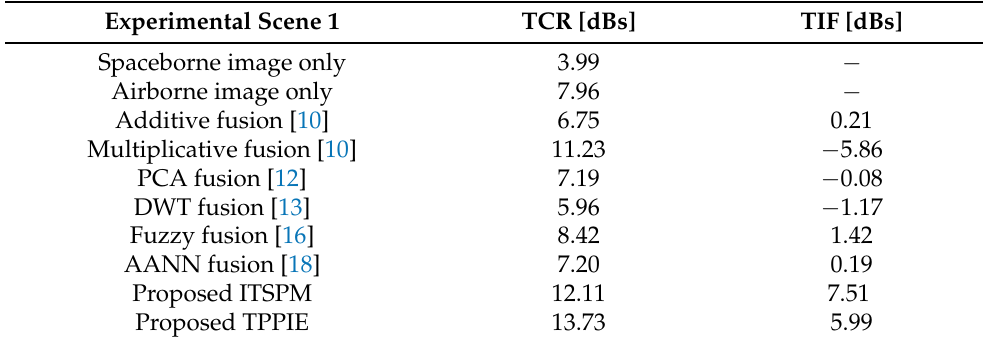
Table 2. TCR and TIF (in dBs) Comparisons for Experimental Scene 1. The proposed TPPIE method attained the highest TCR, and the proposed ITSPM method attained the highest TIF.